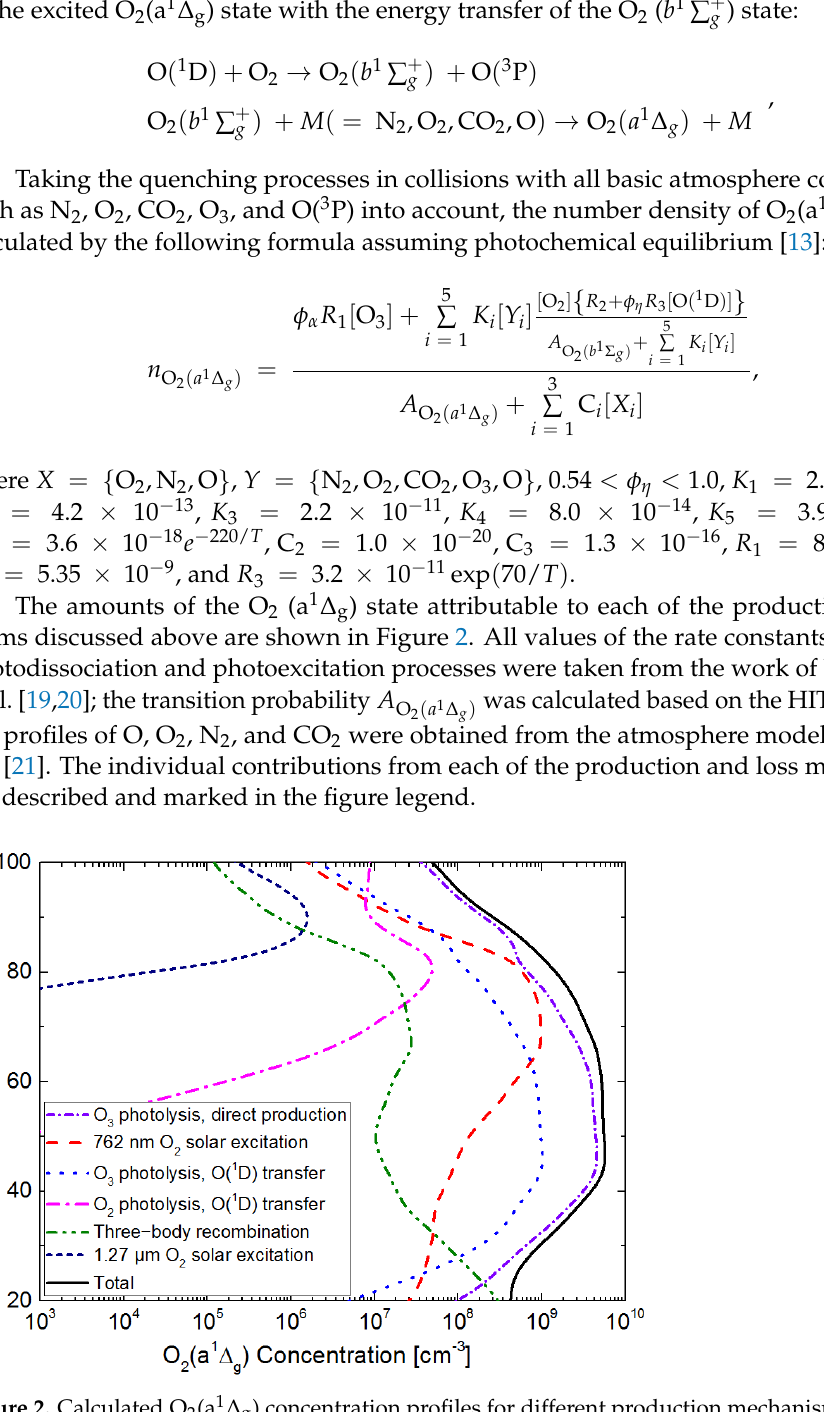
Figure 2. Calculated O 2 (a 1 Δ g ) concentration profiles for different production mechanisms.